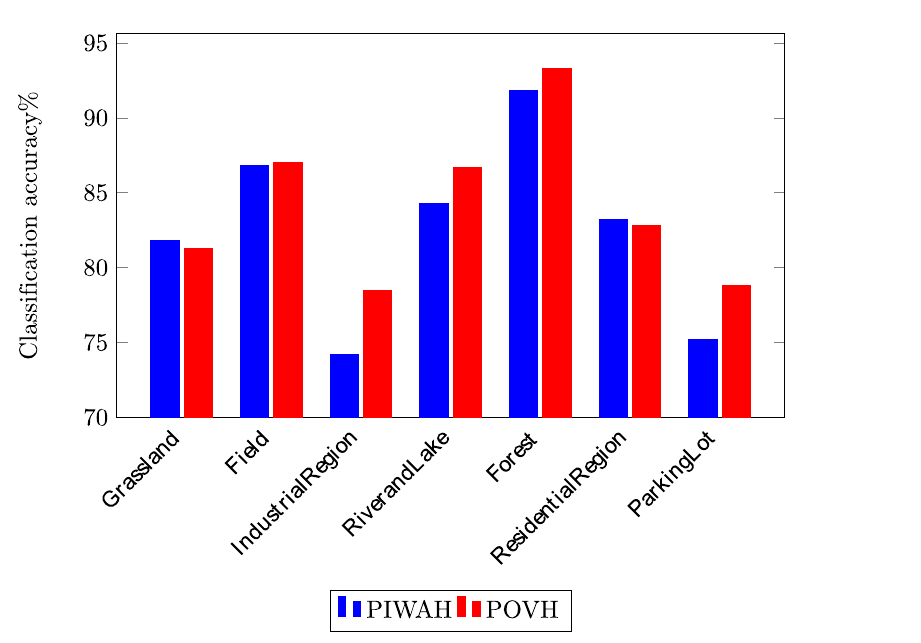
Fig 11. Class-wise comparison while using RSSCN dataset.